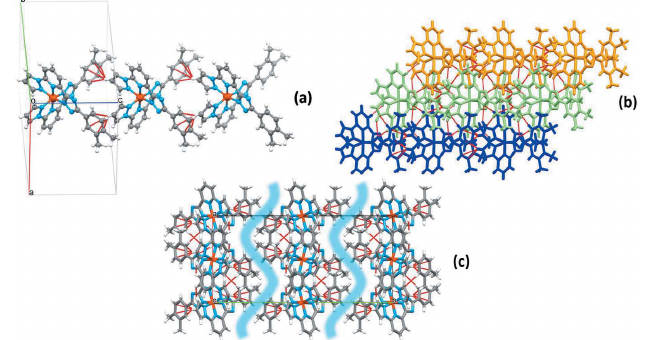
Figure 2 ( a ) A fragment of the mono-periodic supramolecular columns formed by stacking of molecules along the c axis. ( b ) Di-periodic supramolecular layers formed by stacking of the supramolecular columns. For a better representation, each column has a different colour. Red dashed lines represent weak hydrogen bonds. ( c ) Stacking of the di-periodic layers along the c axis. Blue shaded areas correspond to the interlayer space without intermolecular interactions shorter than the sum of the van der Waals radii. The methanol molecules are not shown for clarity.